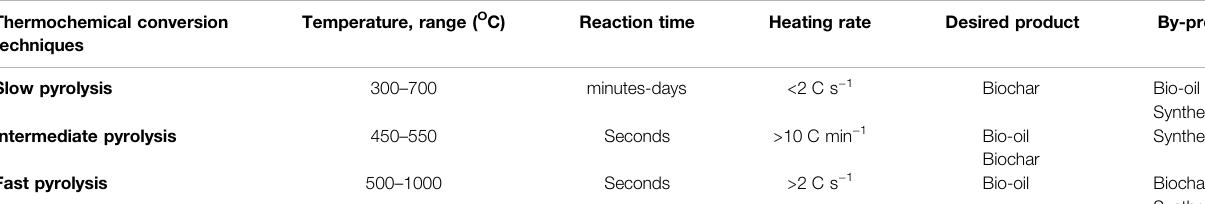
TABLE 3 | Thermochemical conversion technique (pyrolysis) and products (desired and by-products) (Wang et al., 2020; Kazawadi et al., 2021). Thermochemical conversion techniques